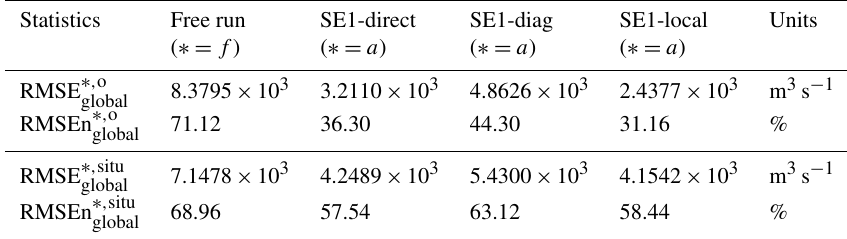
Table 4. Global statistics for experiments with different localization